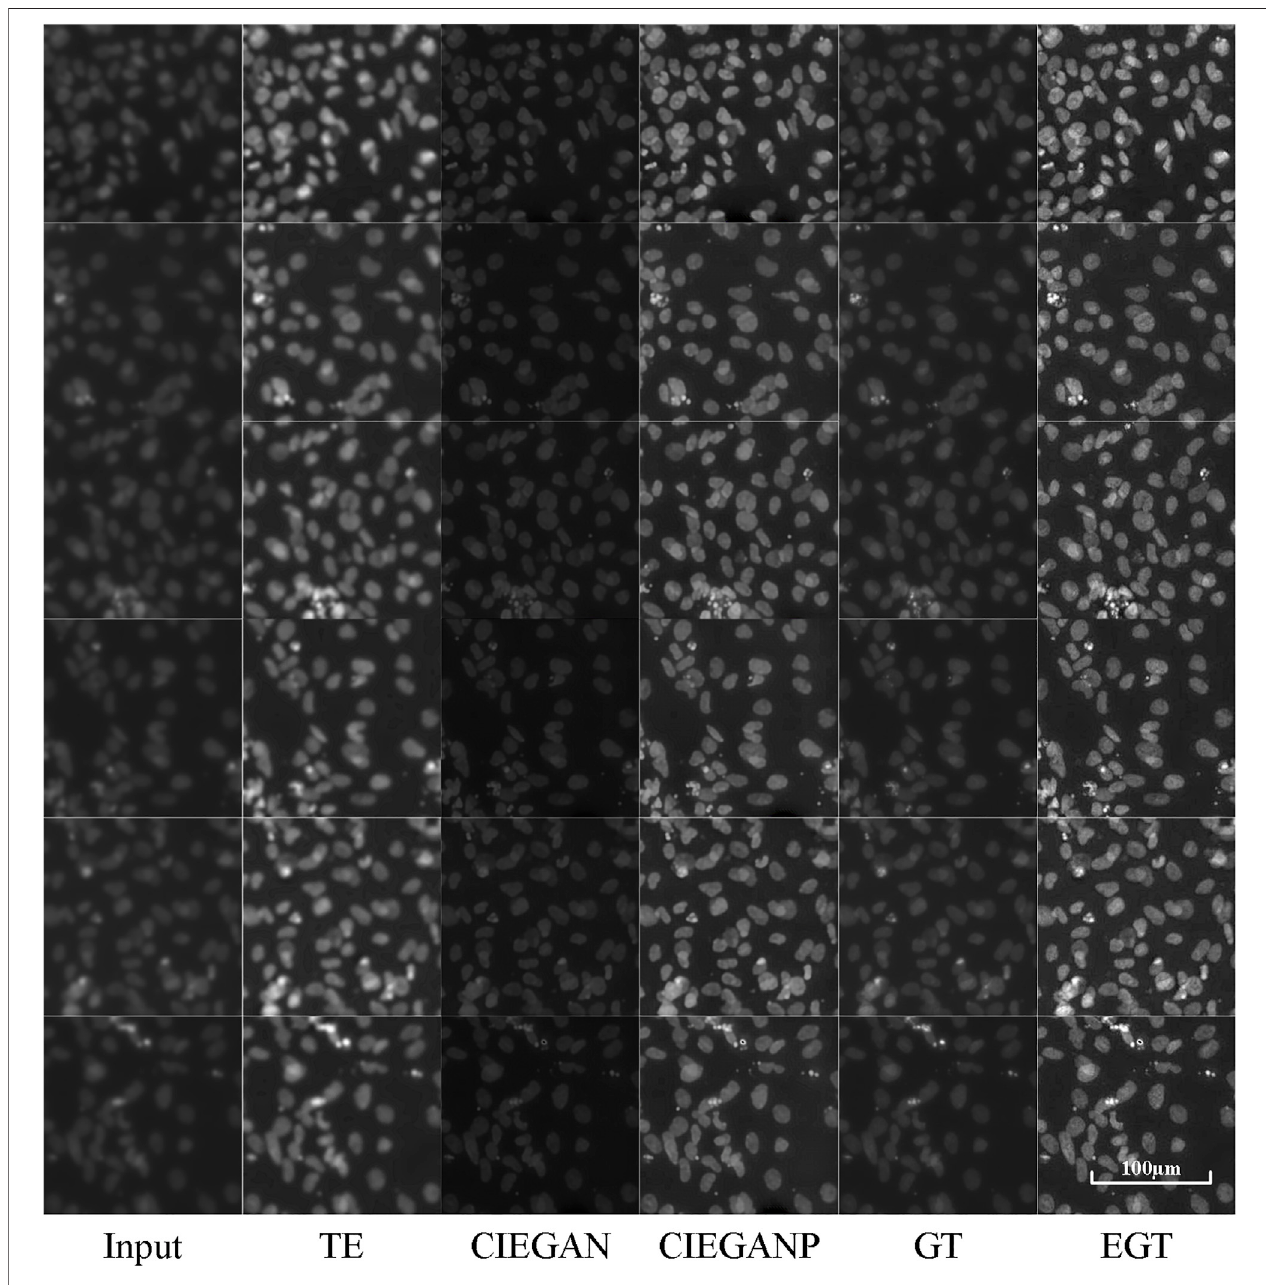
FIGURE 6 | Enhancement results of Hoechst 33342 fl uorescence microscopy images of the iPSC-CM differentiation experiment. TE stands for the traditional enhancement method, CIEGAN and CIEGAN plus (CIEGANP) are our methods, GT is the ground truth, and EGT is the enhanced ground truth.